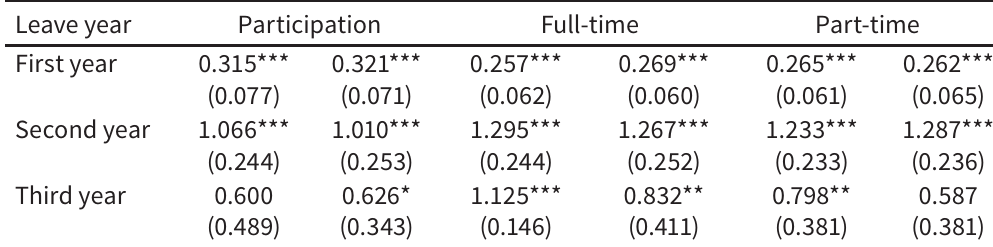
Average marginal effects for maternal childcare